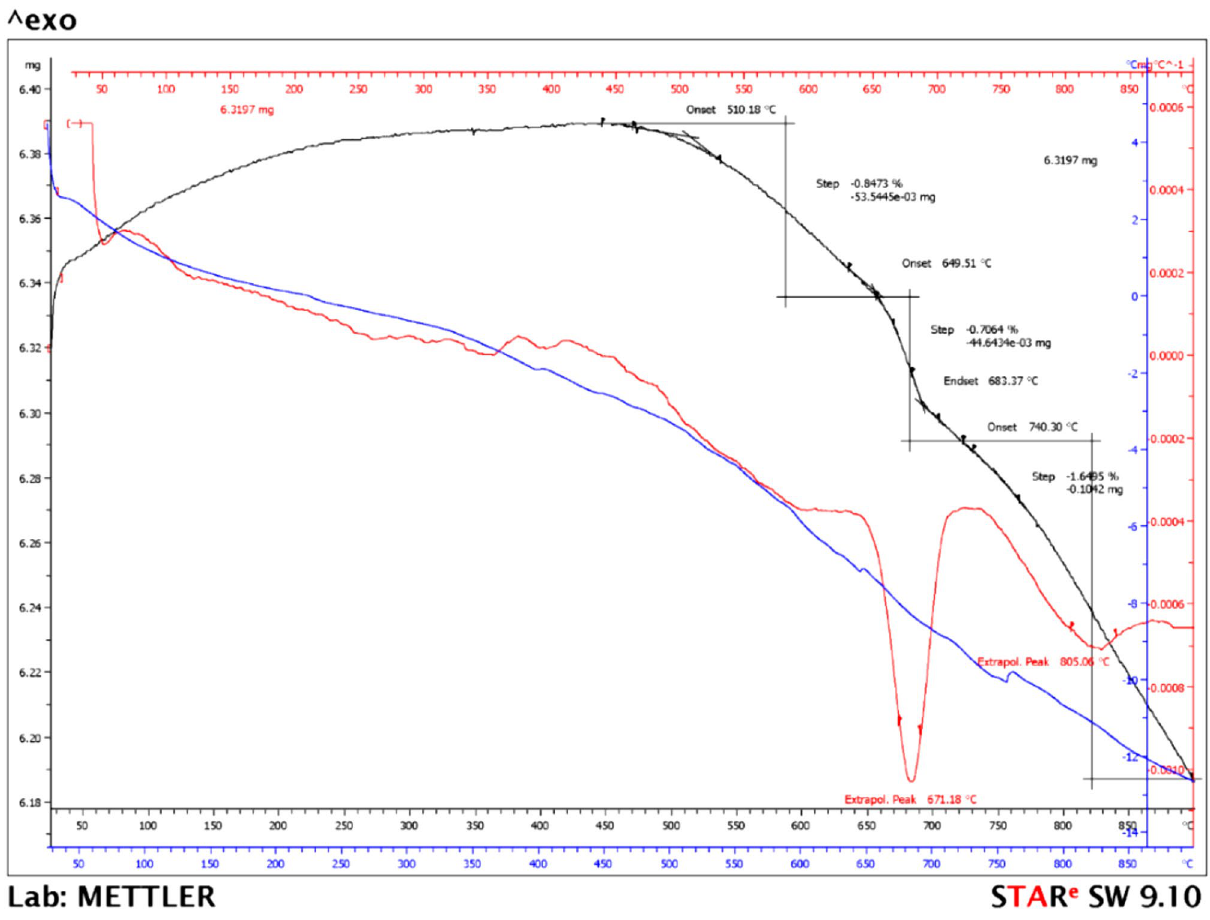
Figure 19. TGA of fly ash after Congo Red dye adsorption.